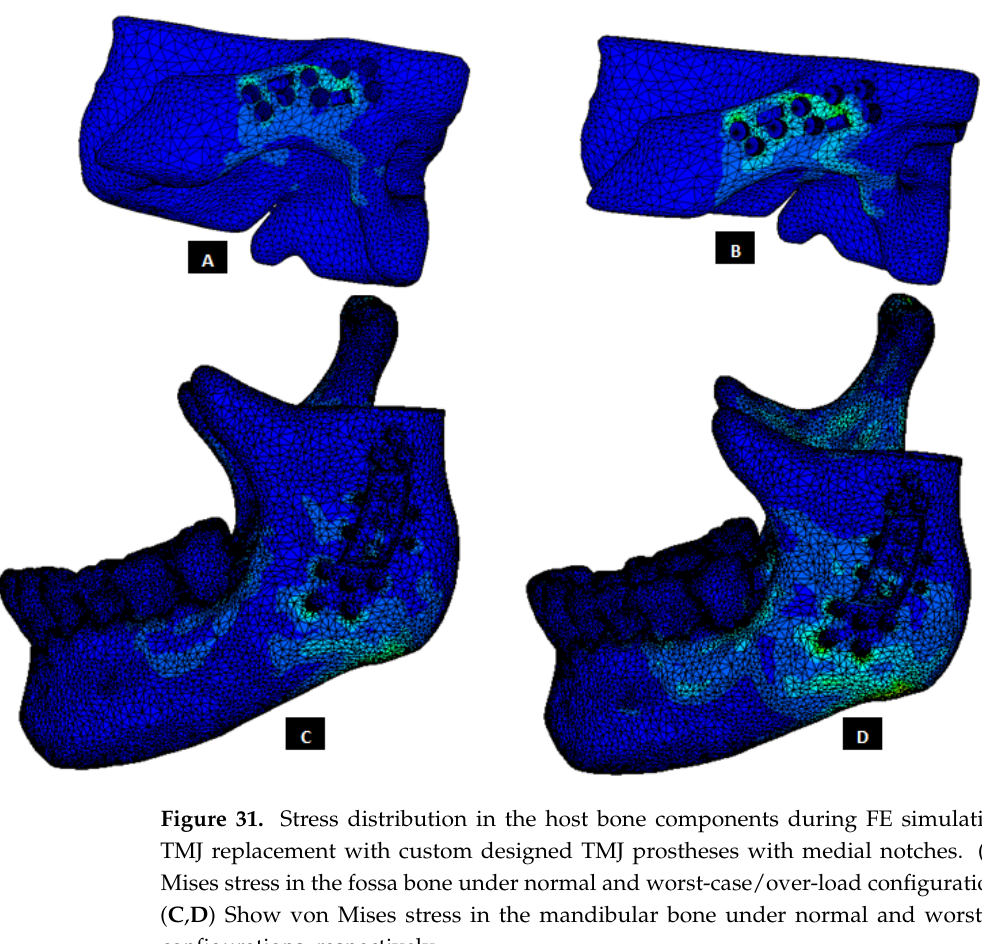
Figure 31. Stress distribution in the host bone components during FE simulations of the total TMJ replacement with custom designed TMJ prostheses with medial notches. ( A , B ) Show von Mises stress in the fossa bone under normal and worst-case/over-load configurations, respectively. ( C , D ) Show von Mises stress in the mandibular bone under normal and worst-case/over-load configurations, respectively.